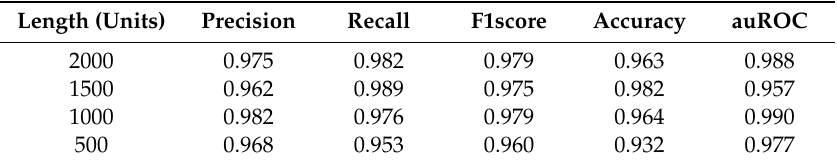
Figure 4. Violin plot for length distribution of RNA sequences in human and mouse datasets. The width of each violin indicates the size of dataset, and the white dots represent the median values of sequence lengths. Table 4. Our model performance on the human2 dataset with different maximum length of input sequences on the BLSTM stage.